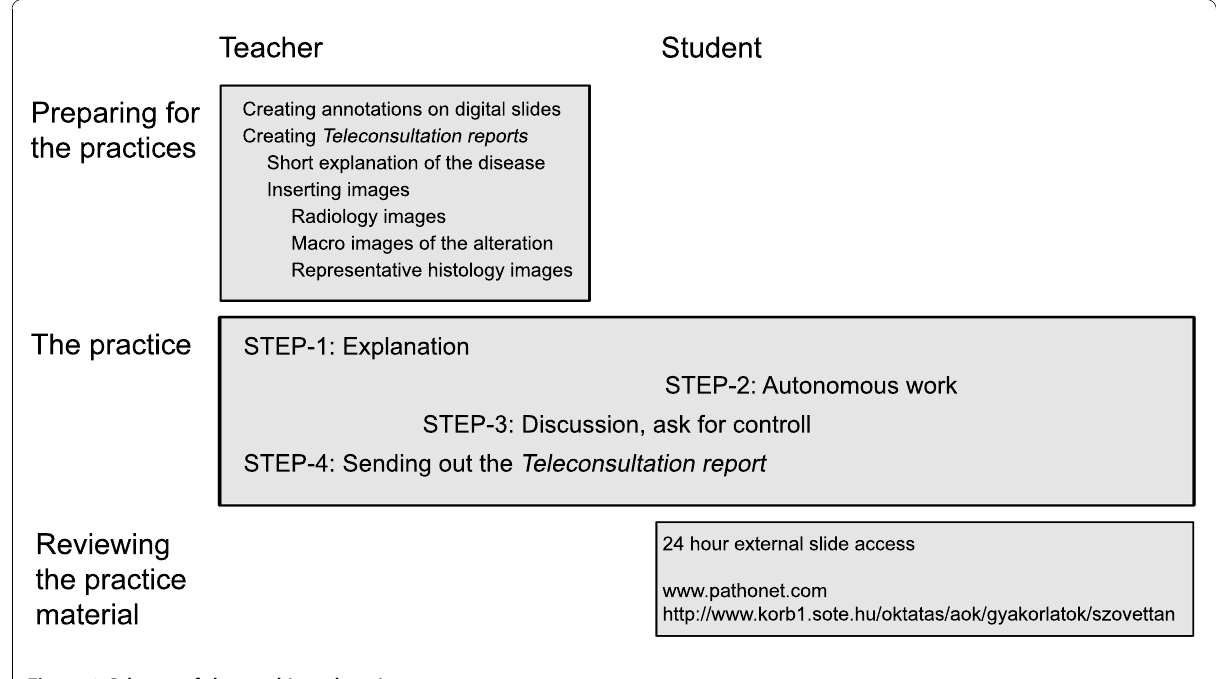
Figure 2 Scheme of the teaching - learning assessment